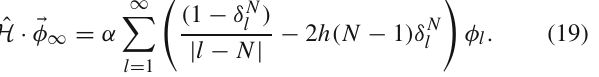
Fig. 4 (Anti-)Collinear behaviour of the gluon Green’s function in the BFKL equation